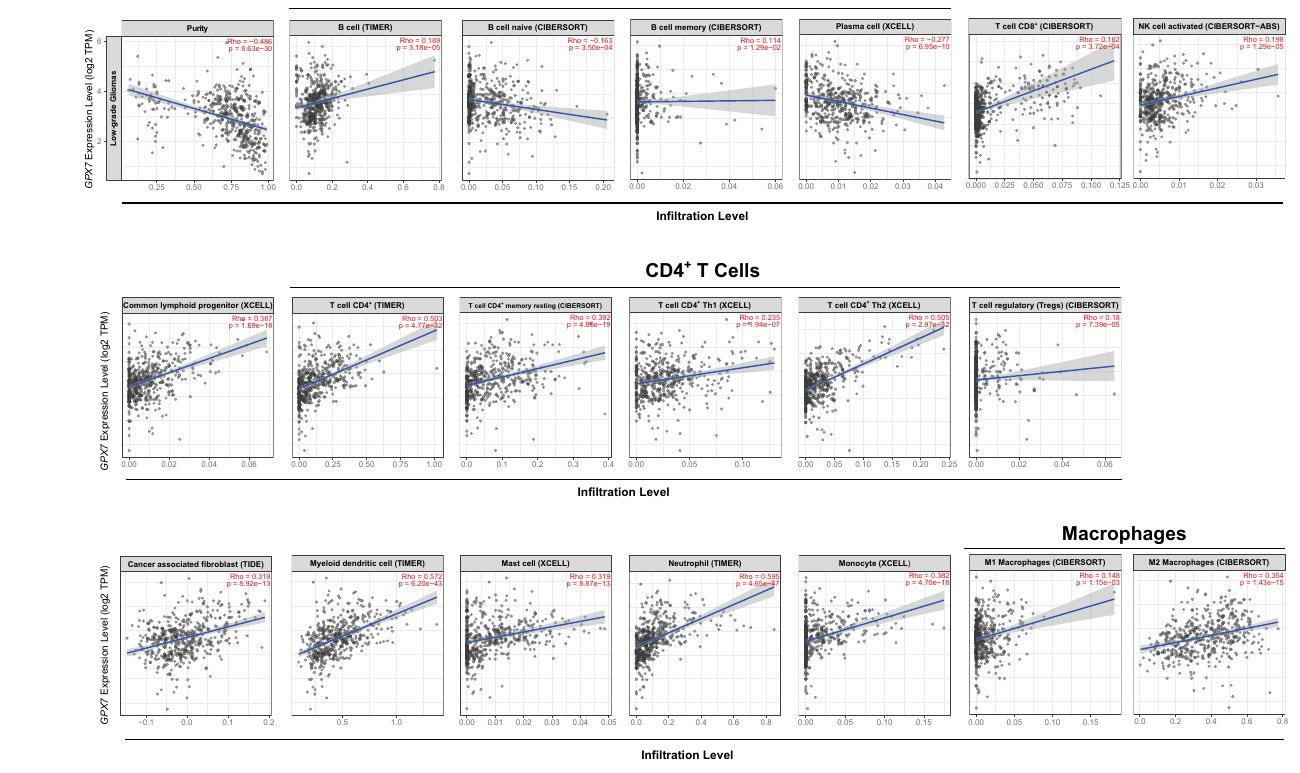
Figure 10. Correlation of GPX7 expression with immune infiltration level in LGG (TCGA dataset) via Tumor Immune Estimation Resource (TIMER) database. All spearman correlations were adjusted for tumor (Fig. 9b). By contrast, marked upregulation of the metabolic regulation of mitochondrial dynamics, translation and ribosomal synthesis signature along with downregulation of a synaptic transmission signature was seen in GBM (Fig. 9c). Our data here provide a basis to explore clinically relevant biological processes involved in glio- magenesis that can be used as potential targets in translational medicine. GPX7 expression is associated with immune cell infiltration. Given the heterogeneity of the tumor immune microenvironment, the close relationship between immunological features and the therapeutic response in gliomas 102,103 , and the association found between GPX7 -co-expressed genes with immune-related gene ontology terms, especially in LGG, we reasoned that GPX7 expression could have potential to impact the immune cell infiltration. Here, we found that GPX7 was negatively associated with the tumor purity in LGG ( ρ = − 0.486; p = 8.63e−30) (Fig. 10 and Supplementary Table S7) but positively correlated to it in GBM ( ρ = 0.311; p = 2.02e−04) (Fig. 11 and Supplementary Table S7). These results are in accordance with the finding of gene ontology terms for GPX7 -co-expressed genes being related to stromal reactions (e.g.: immune cell infiltration and IFN-I response) in LGG, but being mainly related to metabolic processes in GBM, suggesting that while in LGG GPX7 activation directly impacts the tumor microenvironment, in GBM the affected processes are tumor- cell intrinsic. Moreover, in LGG, GPX7 expression was positively correlated with multiple immune-stromal cells, such as B cells ( ρ = 0.189; p = 3.18e−05), common lymphoid progenitors ( ρ = 0.387; p = 1.69e−18), monocytes ( ρ = 0.382; p = 4.70e−18), M1 ( ρ = 0.148, p = 0.001) and M2 macrophages ( ρ = 0.354, p = 1.42e−15), mast cells ( ρ = 0.319; p = 8.87e−13), myeloid dendritic cells ( ρ = 0.572; p = 6.20e−43), neutrophils ( ρ = 0.594; p = 4.65e−47), CD4 + T cells (LGG, ρ = 0.503; p = 4.77e−32), Treg cells ( ρ = 0.180; p = 7.39e−05), CD8 + T cells ( ρ = 0.162; p = 0.0003), NK cells ( ρ = 0.198; p = 1.29e−05) and cancer-associated fibroblasts (CAFs, ρ = 0.319; p = 8.92e−13) (Fig. 10; Supple- mentary Table S7). Furthermore, after purity-related adjustment, we found that GPX7 expression was related to high intratumor expression of most markers of T cells (general) ( CD3E, CD3D, CD2 ), B cells ( CD19, CD79A ), monocytes ( CD86, CD115 ), TAMs ( CCL2, CD68, IL10 ), M2 Macrophages ( CD163, VSIG4, MS4A4A ), neutrophils ( CD11b, CCR7 ), dendritic cells ( HLA-DPB1, HLA-DQB1, HLA-DRA, HLA-DPA1, BDCA-1, BDCA-4 ), CD4 + T cells ( CD4, CD45RA ), Th1 cells ( T-bet, STAT4, STAT1, IFN-g, TNF-a ), Th2 cells ( GATA3, STAT6, STAT5A ) and Treg cells ( FOXP3, CCR8, STAT5B, TGFβ ) (Supplementary Table S8). Thus, these data indicated that high GPX7 expression is associated with a highly inflammatory microenvironment and immune exhaustion in these tumors. Otherwise, in GBM, GPX7 only positively correlated with common lymphoid progenitors ( ρ = 0.485; p = 1.89e−09), CD8 + ( ρ = 0.290; p = 0.0005), myeloid-derived suppressor cells ( ρ = 0.379; p = 4.93e−06) and CAFs ( ρ = 0.220; p = 0.009), while it was negatively correlated with B cells ( ρ = − 0.322; p = 0.0001), eosinophils